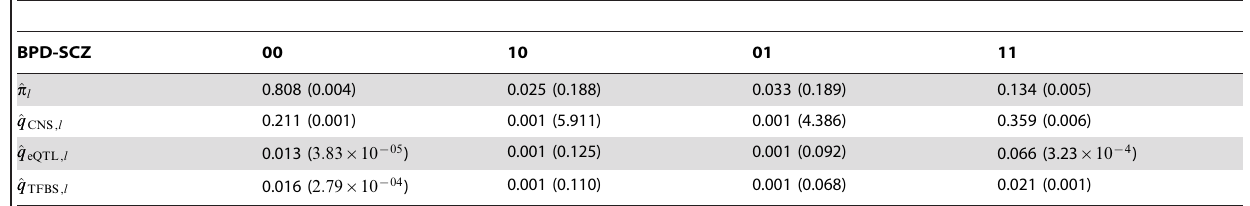
Table 4. The estimated parameters and their standard errors for the joint analysis of BPD and SCZ, together with multiple annotation data: The CNS gene set, eQTL and TFBS.